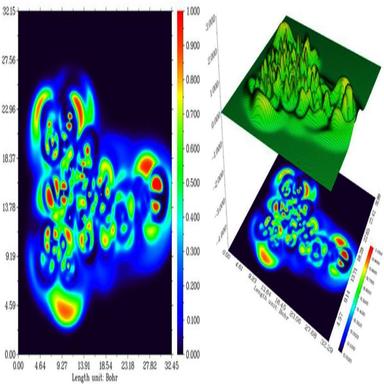
ELF Color filled map and Shaded surface map with projection effect of hydrogen bonding region in H2L.